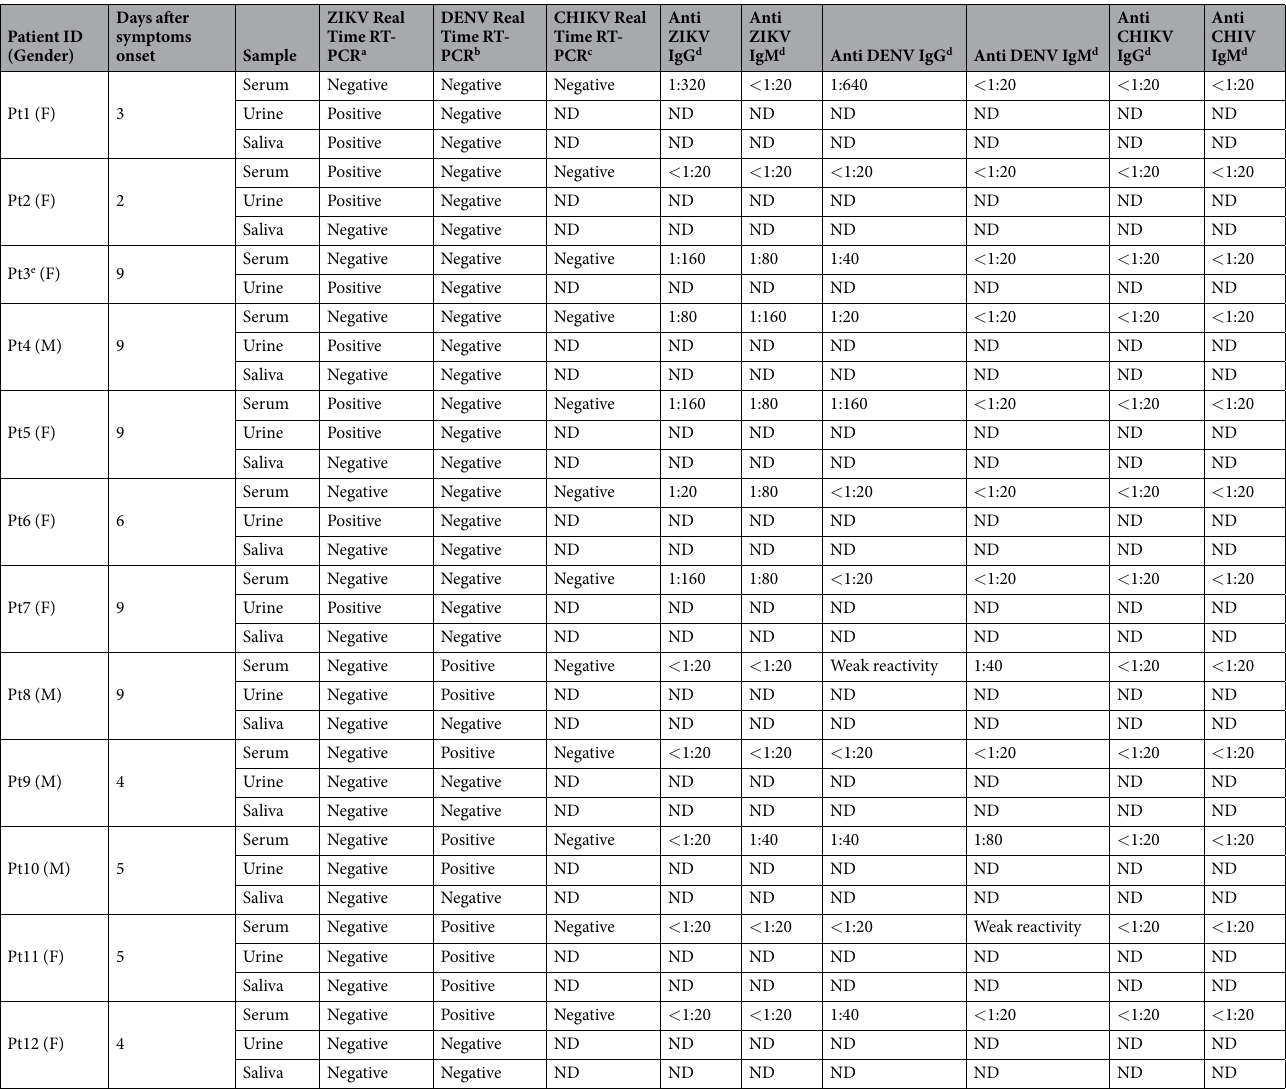
Table 2. Serological and virological data of ZIKV- and DENV-infected patients. DENV: dengue virus; ZIKV: Zika virus; RT-PCR: Reverse transcription polymerase chain reaction; ND: not done. a ZIKV specific